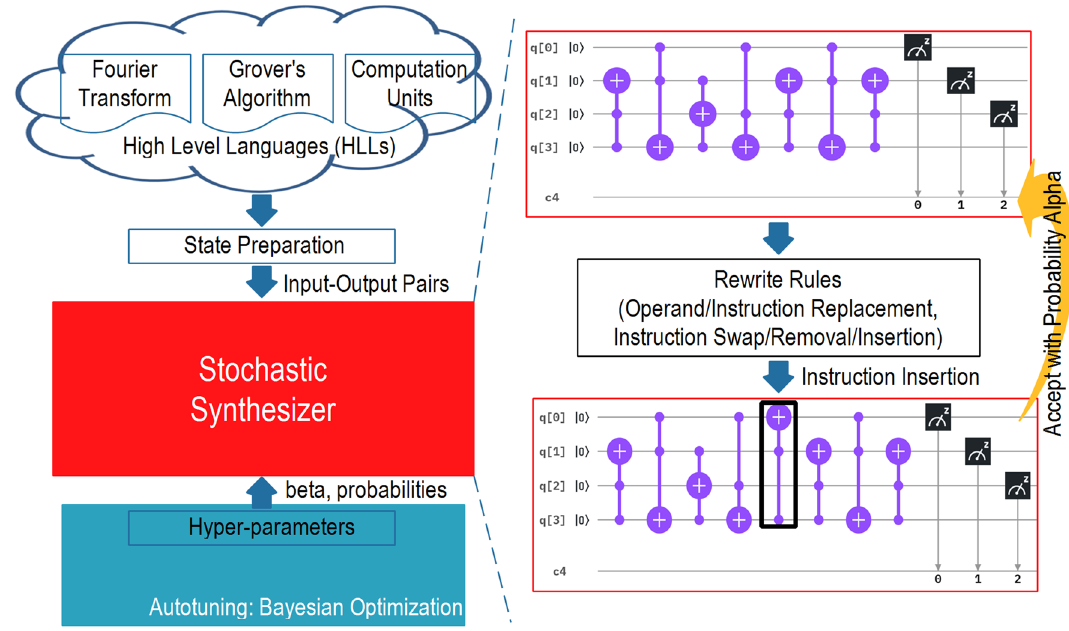
Figure 1. The overview of the automatic quantum program synthesis from high-level languages. We first prepare input–output pairs from high-level languages. These pairs guide the stochastic synthesizer with hyper- parameters to search towards the quantum program with the lowest cost to best fit them. Inside the synthesizer, a quantum program is initially proposed at random. Followed by acting on randomly chosen rules such as replacement, insertion, and deletion, a new proposed program is generated and accepted with a probability inversely proportional to the cost. This process is repeated until either the synthesizer finds the correct program, or the budget is